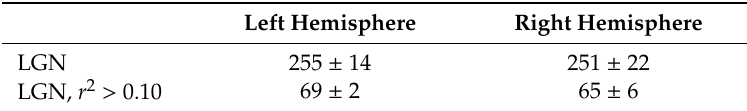
Table 1. The mean volume (mm 3 ) of the left and right LGN ± subject-wise SEM. Also shown are the mean activated volumes after applying the statistical